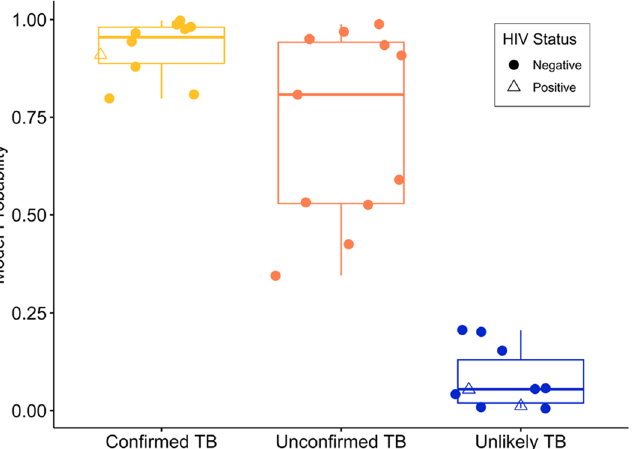
Figure 4. The output probabilities that each patient has TB disease from the random forest classifier across the TB categories. Patients with a probability of over 50% are assigned a label of having TB disease. Despite two unconfirmed TB patients having probabilities below 50%, there is clear differentiation in model probabilities between the unconfirmed and unlikely TB groups. Boxplots show the quartiles of the data (first line is the first quartile, midline is the median, third line is the third quartile) where whiskers represent 1.5 × IQR (inter- quartile range). Figure created in R 73 using ‘ggplot2’ 84 and ‘ggpubr’ 85